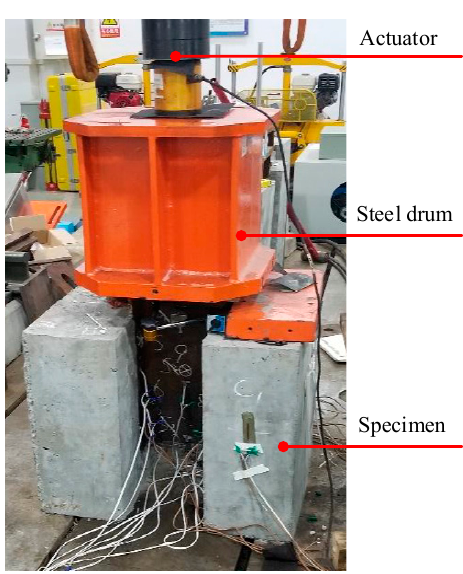
Figure 4. Push-out test setup and test specimen layout.